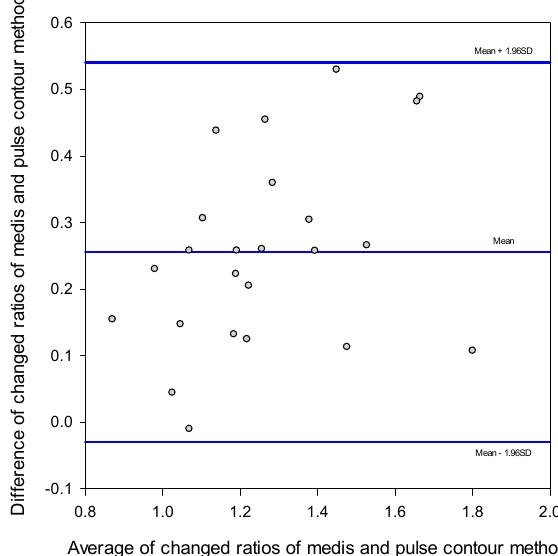
Figure 5. ( a ) The correlation of changed ratios in the SV between the pulse contour method and Medis, r 2 = 0.712. ( b ) The correlation of changed differences in the SV between the pulse contour method and Medis, r 2 = 0.709.